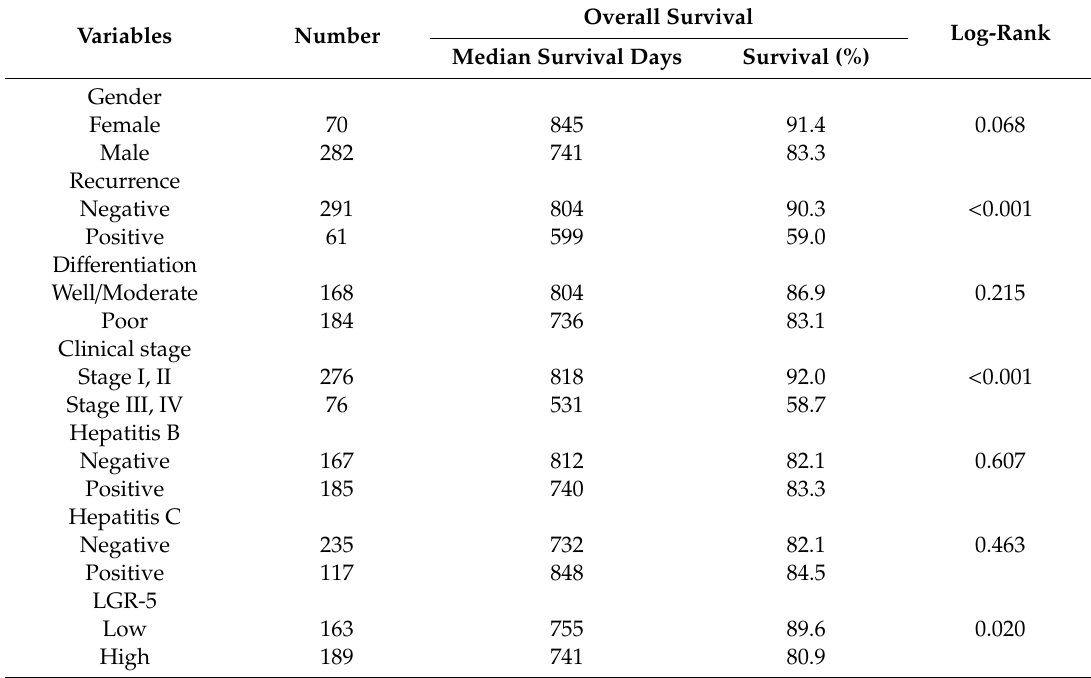
Table 2. Univariate analysis of overall survival in total HCC